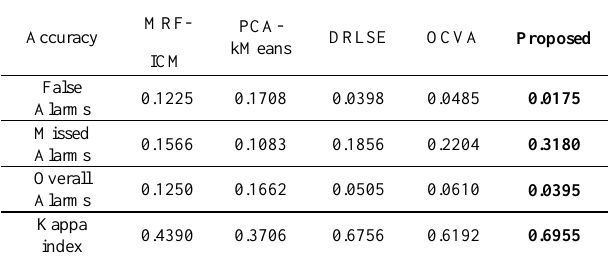
Table 1. Performance comparisons against different